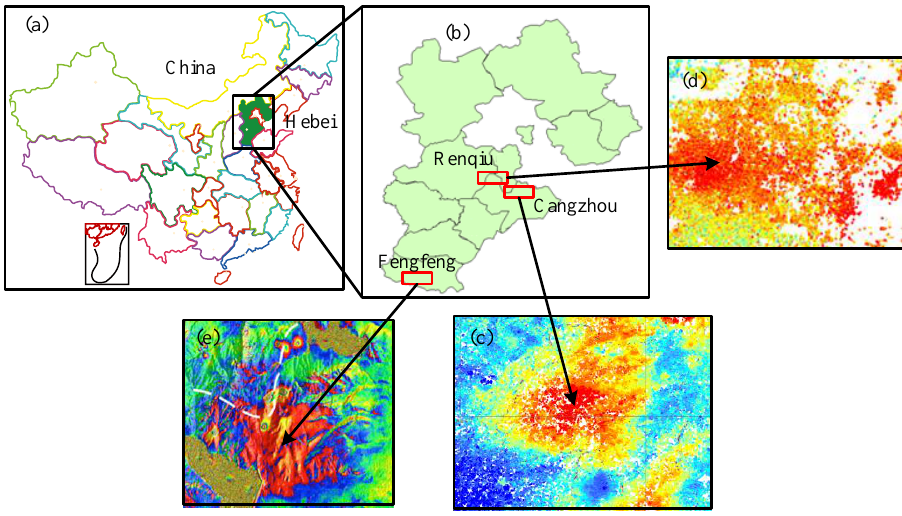
Figure 1. (a) Vicinity map of Hebei Province within China; (b) Vicinity map of the Changzhou, Fengfeng, and Renqiu study sites within Hebei; Soil sample collection sites from subsided land (red regions) of Changzhou (c), Renqiu (d) and Fengfeng